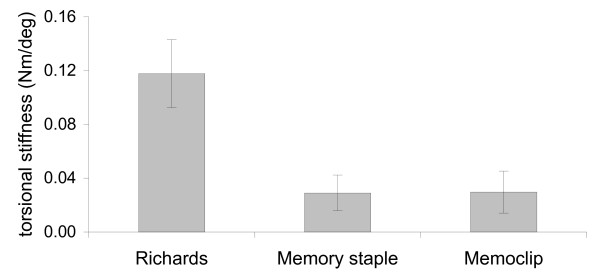
Torsion stiffness for different staples.